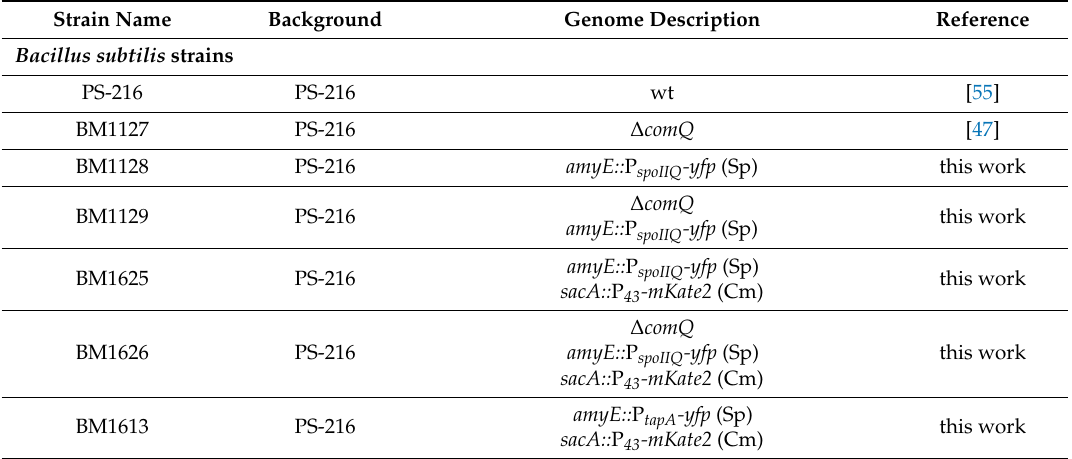
Table 1. Bacterial strains used in this